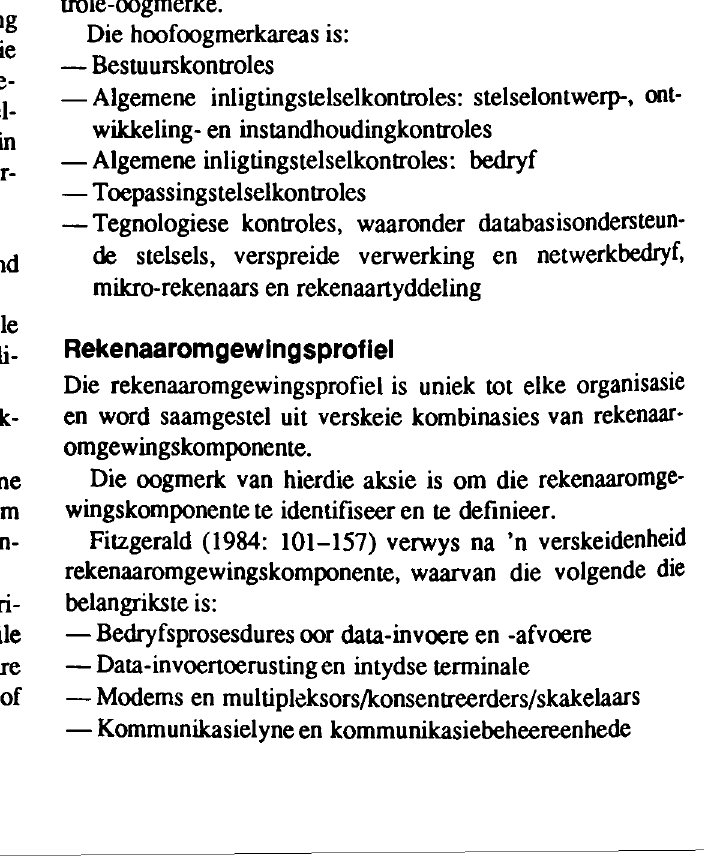
Figuur 1 'n Strategiese fonnuleringsprosesmodel